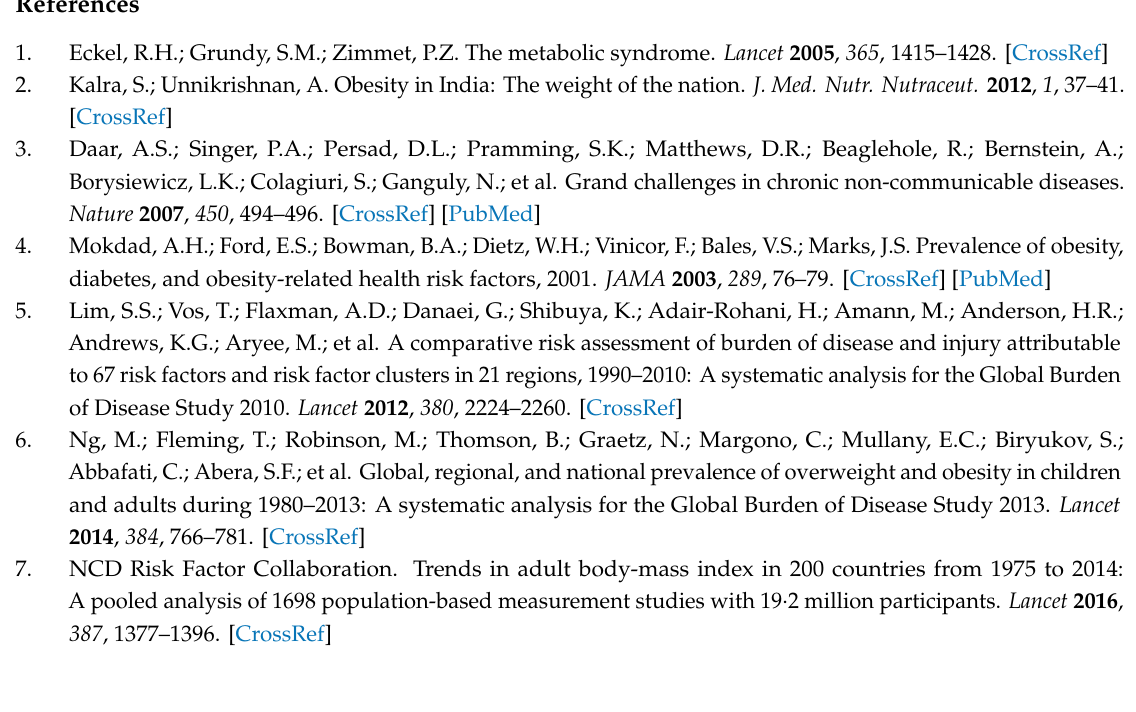
Table S1: Questions used and procedures followed in identifying the presence of overweight / obesity, hypertension, and diabetes among adults under the National Family Health Survey